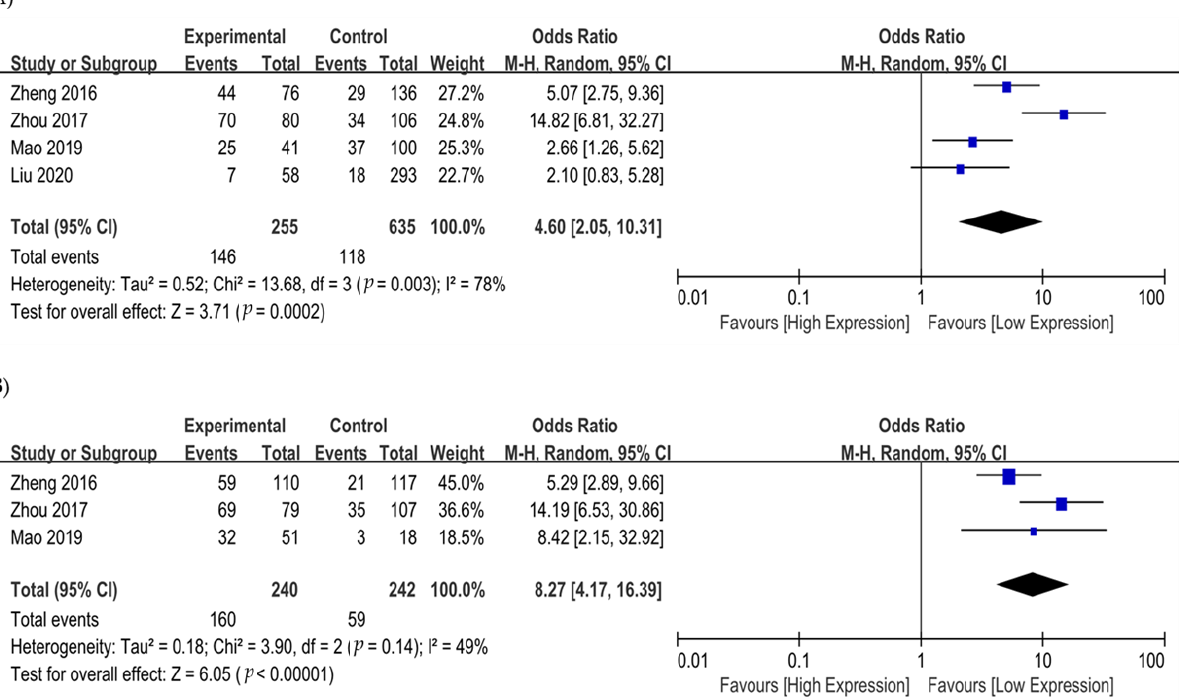
Figure 3 . Forest plot showing hazard ratios for ( A ) overall survival, and ( B ) progression-free sur- vival, according to ROR1 expression.